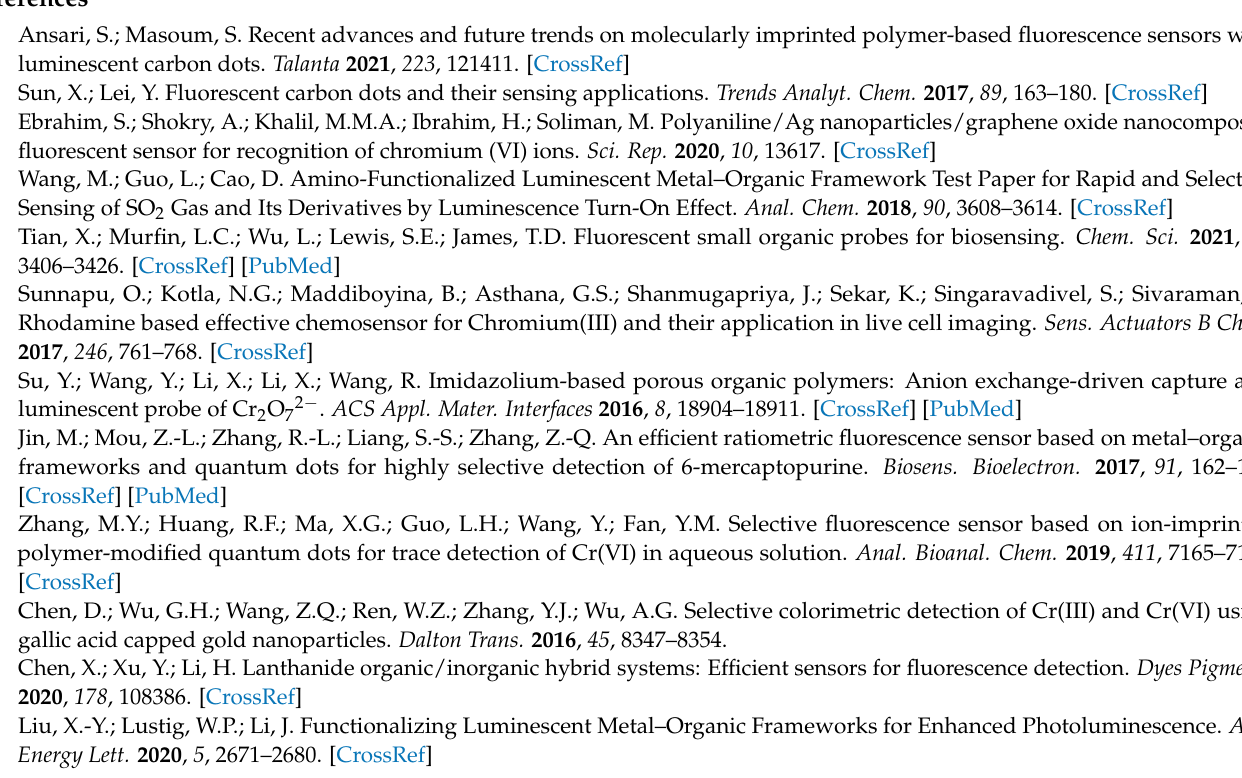
for 24 h. Figure S10: UV-vis spectra of 1 before and after immersing in Cr 3+ , Al 3+ , Fe 3+ aqueous solutions for 24 h. Figure S11: Fluorescence emission spectra of 1 in H 2 O suspension (1 mg/3 mL) before and after addition of interfering/analyte ions at room temperature upon excitation at 306 nm. Figure S12: Fluorescence intensity traces ( λ em = 438 nm) for the H 2 O suspensions of 1 upon incremental addition of Cr 2 O 72 − and CrO 42 − ions when excited at 306 nm, following the first-order exponential decay. Figure S13: Linear region of fluorescence intensity ( λ em = 438 nm) for the H 2 O suspensions of 1 upon incremental addition of Cr 2 O 72 − and CrO 42 − ions when excited at 306 nm. The following table lists the relevant parameters of LOD for the H 2 O suspensions of 1 toward Cr 2 O 72 − and CrO 42 − ions. Figure S14: Spectral overlap between the normalized emission spectra of 1 in H 2 O suspensions and the normalized absorption spectra of Cr 2 O 72 − and CrO 42 − in aqueous